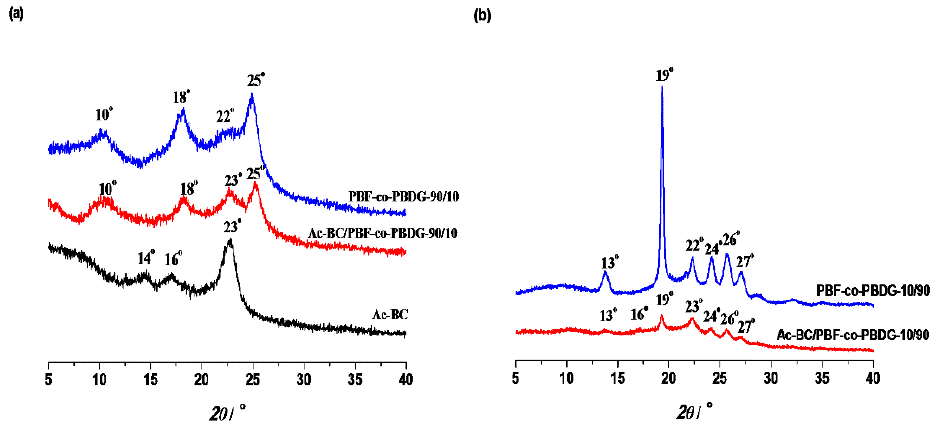
Figure 4. X-Ray diffractograms of: ( a ) Ac-BC/PBF- co -PBDG-90/10 nanocomposite film and corresponding Ac-BC film and PBF- co -PBDG-90/10 components, and ( b ) Ac-BC/PBF- co -PBDG-10/90 nanocomposite film and corresponding Ac-BC film and PBF- co -PBDG-10/90 components. moieties (i.e., PBF- co -PBDG-90/10 to 50/50) roughly displayed the typical diffraction pattern of PBF,